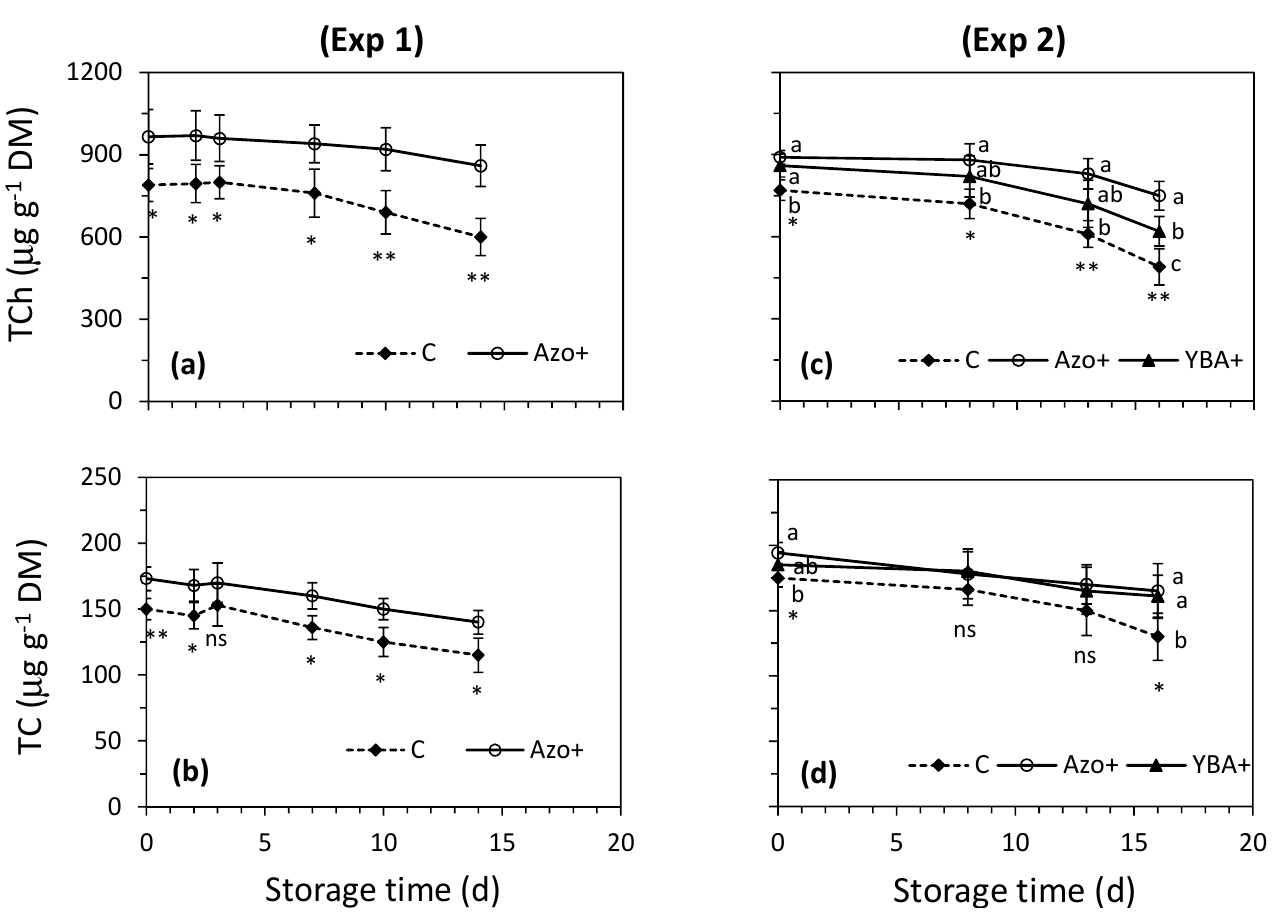
Figure 3. Trend of total chlorophyll (TCh) and total carotenoid (TC) content during the storage of the wild rocket treated with Azoxystrobin (Azo +) at preharvest in Exp 1 ( a , b ), and with Azoxystrobin or an algae-based biostimulant (YBA+) in Exp 2 ( c , d ), and of that relating to the untreated control (C). DM = dry matter. Vertical bars indicate SD (n =3). ns, * and ** indicate F test not significant, significant at P ≤ 0.05 and significant at P ≤ 0.01, respectively. Separation of mean within the days from the start of storage by SNK test ( P = 0.05). Different lower case letter denotes significant differences.